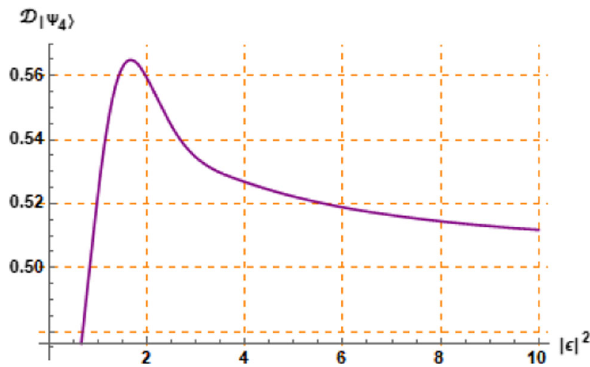
Fig. 11 Plot for the dimensionless quantity in | Ψ 4 (cid:3) state of ETMC states, plotted as a function of coherent parameter | (cid:11) | . Note that the (cid:3) states are always semiclassical states with D T (cid:10) 1 for all the | Ψ 4 range of coherent